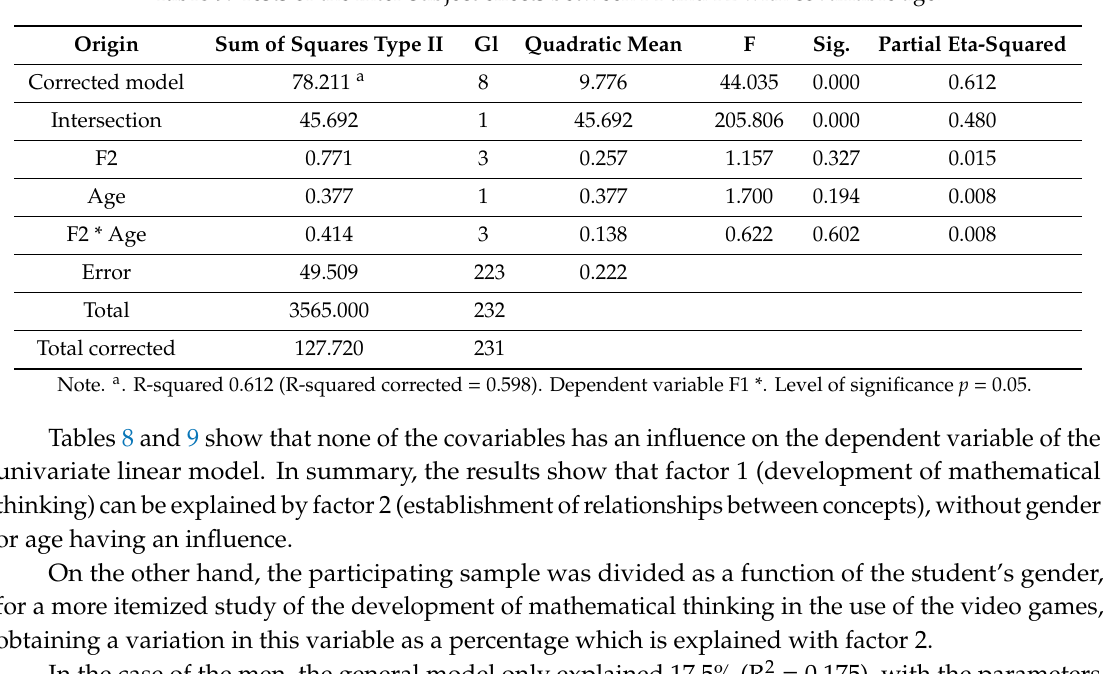
Table 9. Tests of the inter-subject e ff ects between F1 and F2 with covariable